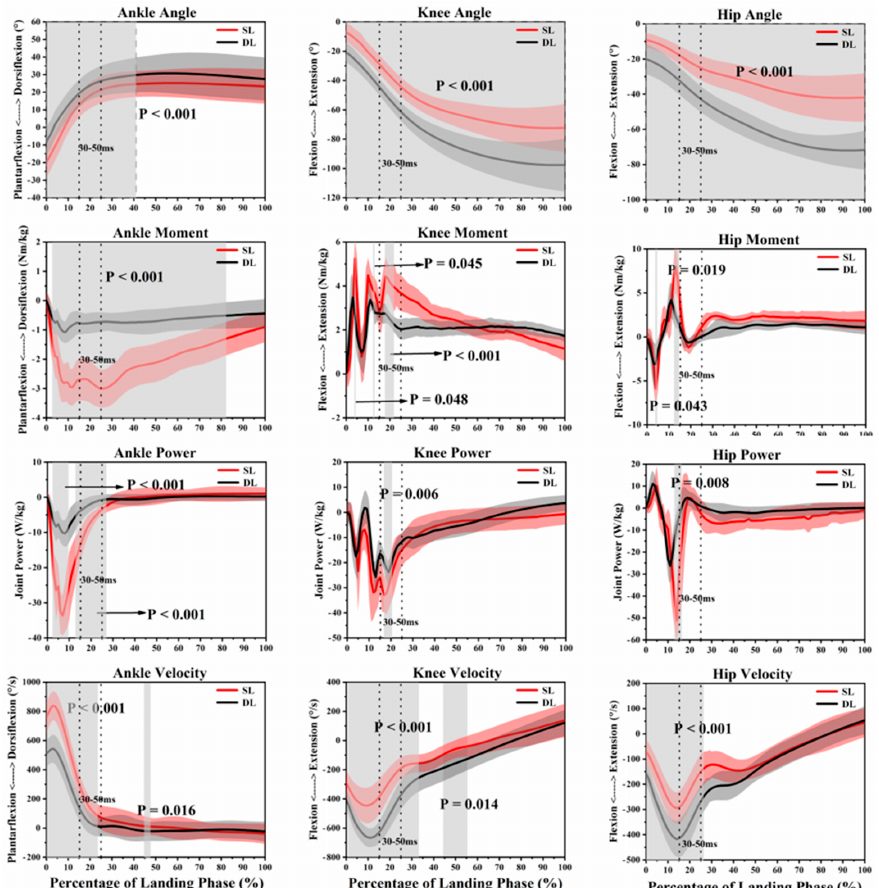
Figure 4. The Statistical Parametric Mapping (SPM) results between single-leg landing (SL) and double-leg landings (DL) tasks following a spike, depicting the mean angle moment power and angular velocity and standard deviation of ankle knee and hip sagittal plane. Two dashed lines are the 30 and 50 ms time frame of initial contact. Grey shaded areas indicate that there are significant differences ( p < 0.05) between SL and DL during the spike landing phase.